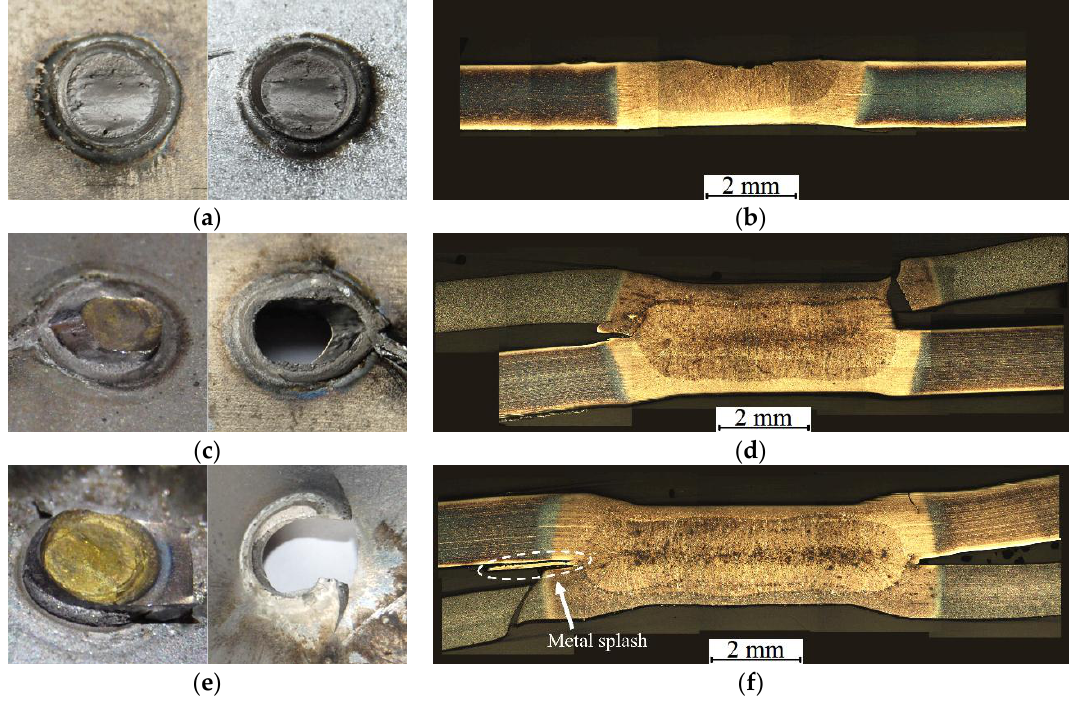
Figure 11. Modes of fractures of the spot welds obtained after the shear tension tests: ( a , b ) interfacial fracture; ( c , d ) button pull with the fracture path mainly along the nugget border; and ( e , f ) button pull with the fracture path through the steel sheet.